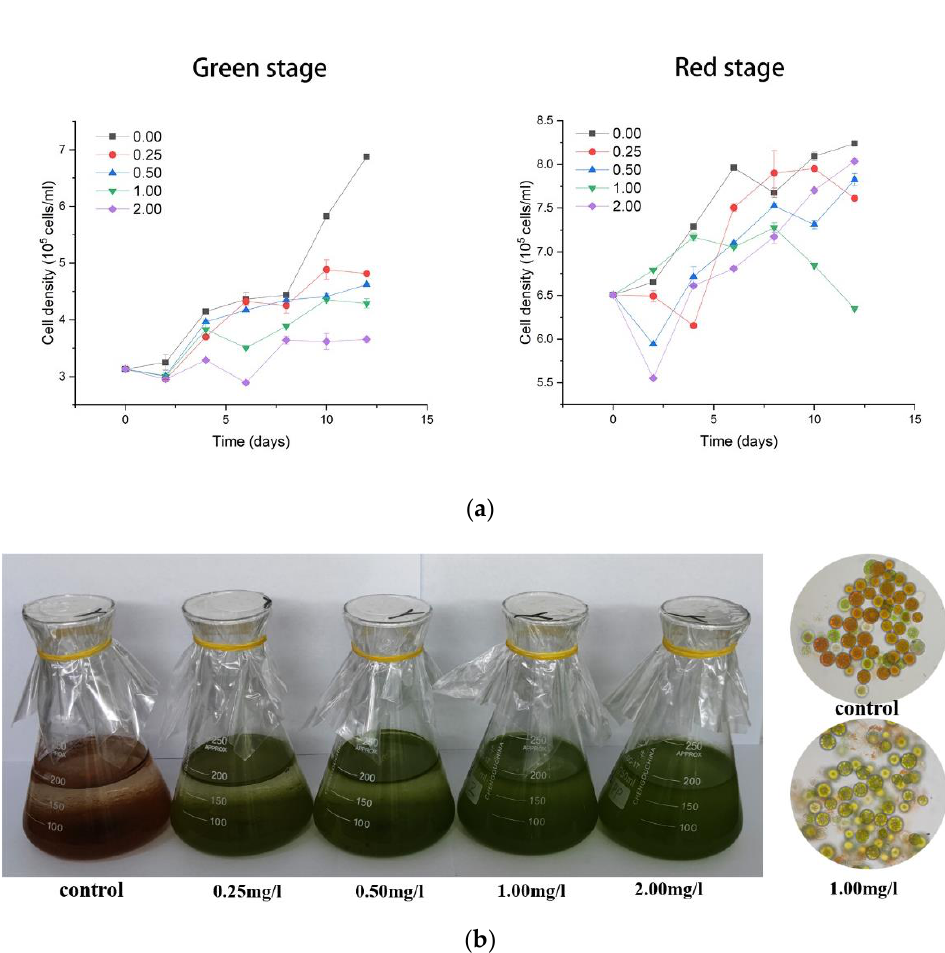
Figure 1. Growth curves and morphological changes of algae treated with different concentrations of fluridone. ( a ) Green stage on the left and red stage on the right. Lines with different colors represent fluridone concentrations of 0.00 mg/L, 0.25 mg/L, 0.50 mg/L, 1.00 mg/L, and 2.00 mg/L. The abscissa represents different days. Values depicted in graphs represent the mean from at least three independent experiments with standard deviations, the same below. ( b ) Observation of algal fluid morphology and microscope field under 0.00 mg/L and 1.00 mg/L treatments.